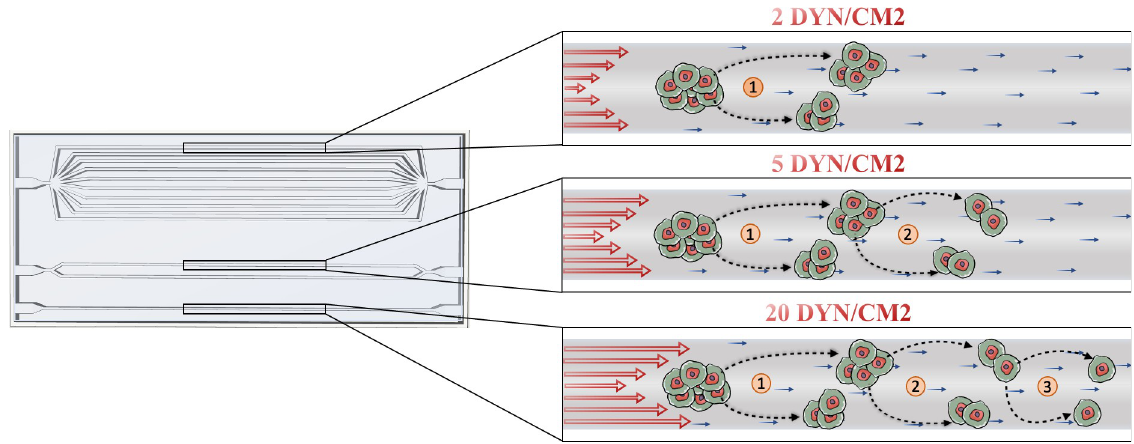
Fig 8. SS induce CTC clusters disaggregation. Schematic representation of the observed effects of increasing levels of SS on the disaggregation of CTC clusters.